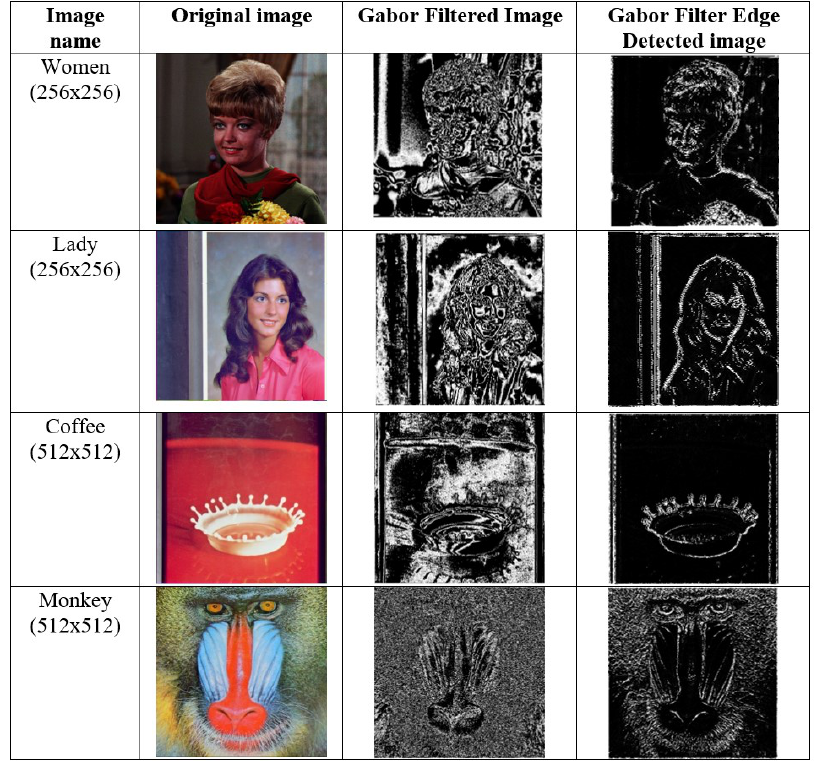
Figure 8. Gabor filter and edge detection techniques on various original